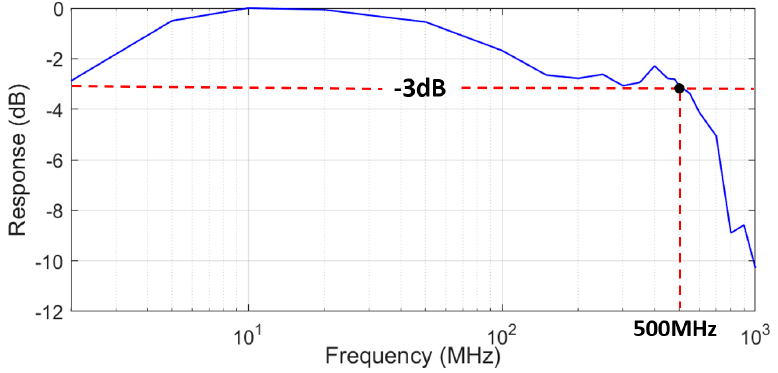
Figure 2. VCSEL (L670VH1) frequency response.